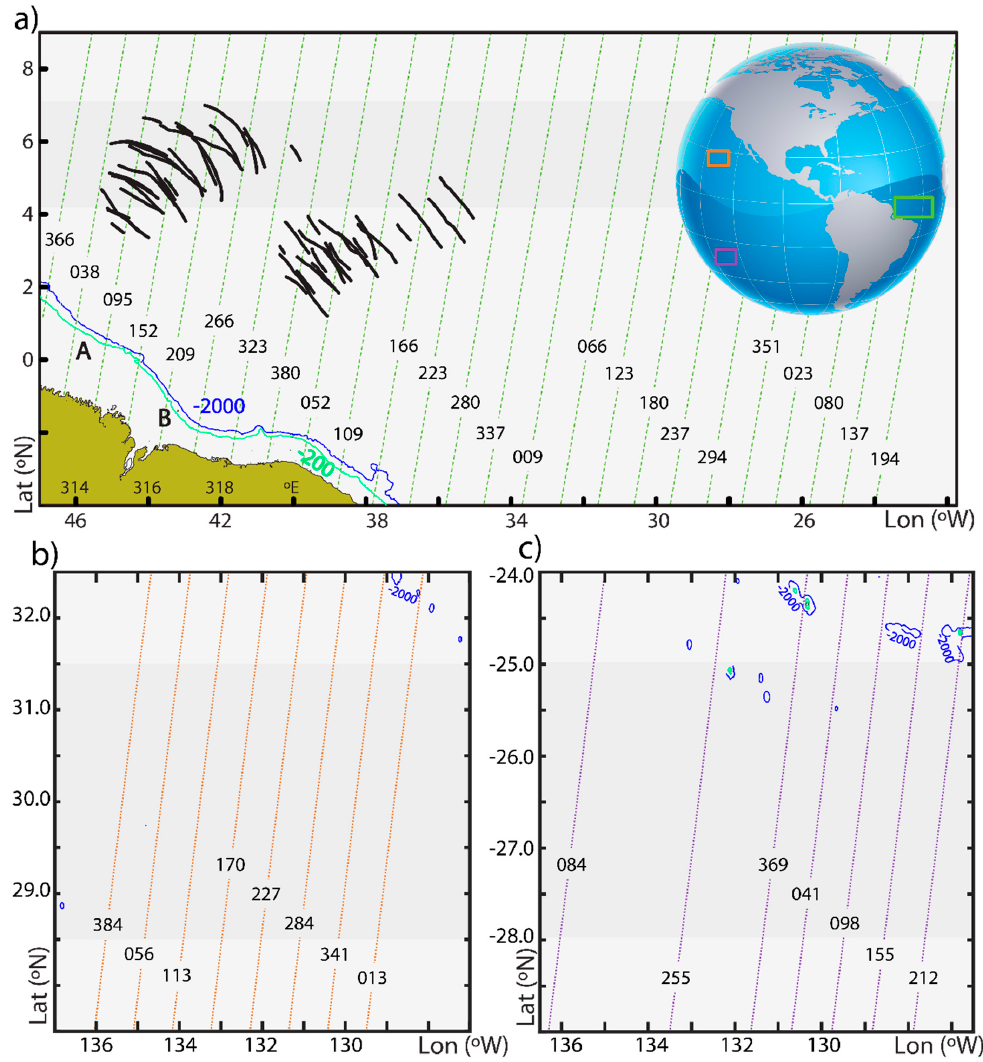
Figure 1. Maps of the study regions. ( a ) The satellite altimetry tracks are displayed in green dashed lines, labelled accordingly with the relative orbit numbers used in Sentinel-3A mission. The region shaded in darker grey corresponds to the latitude range selected for this study. The bold dark curves show the locations of the ISW crests found in Reference [9]. Labels A and B represent the likely origin of the ISWs, and the South American continent is hatched in green. The inset in the upper right corner of the figure shows the relative positions of the three selected study regions. ( b , c ) The same is presented for the North and South Pacific Ocean, respectively. The orange and magenta dashed lines represent the satellite tracks, respectively for the North and South Pacific Ocean. The isobaths of − 200 m and − 2000 m are inserted for reference, respectively in light green and blue. It is seen that all study regions (dark grey areas) are deep water regions.